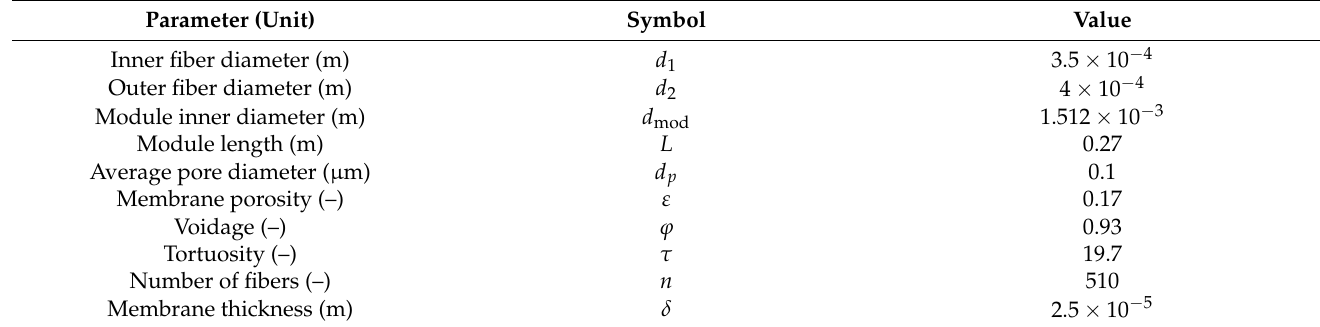
Table 2. Polypropylene HFMC module properties